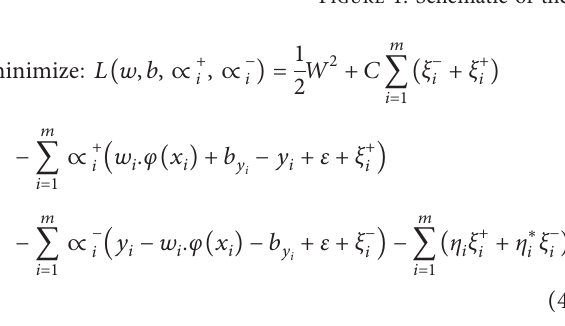
Figure 1: Schematic of the catchment of Cham Siah in